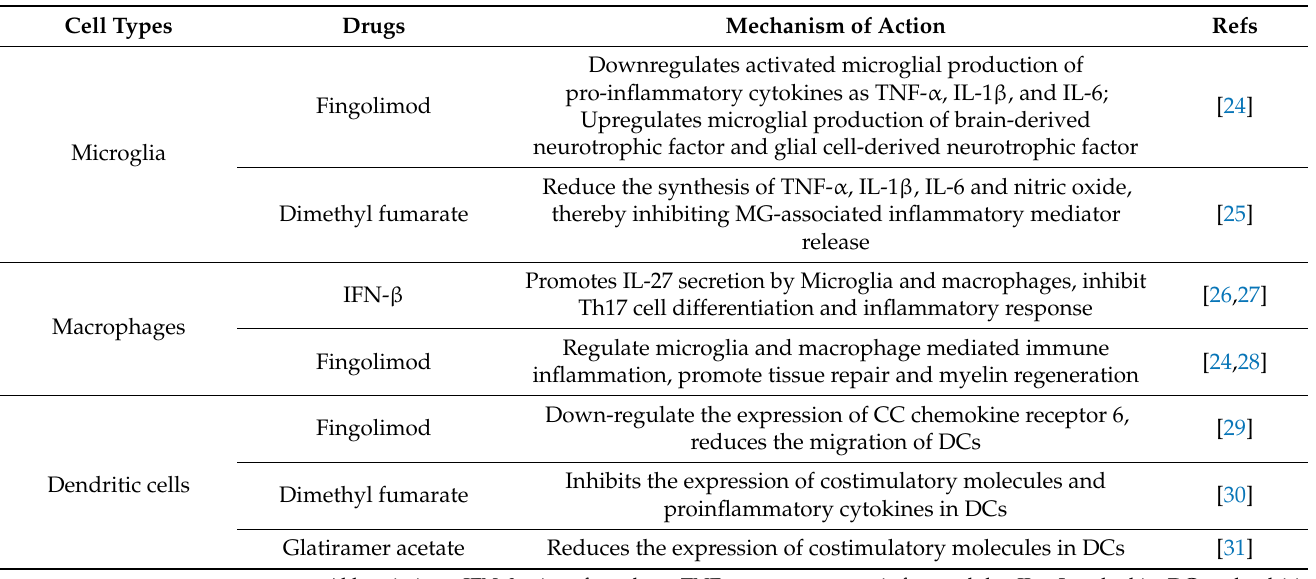
Table 1. Disease-modifying drugs for multiple sclerosis that are approved to act on innate immune